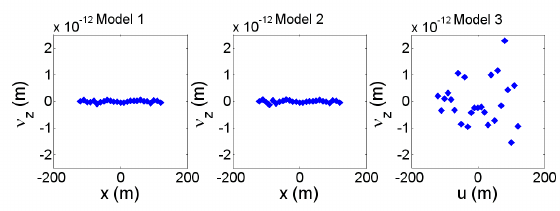
Table 4. Correlation coefficients of Model 3